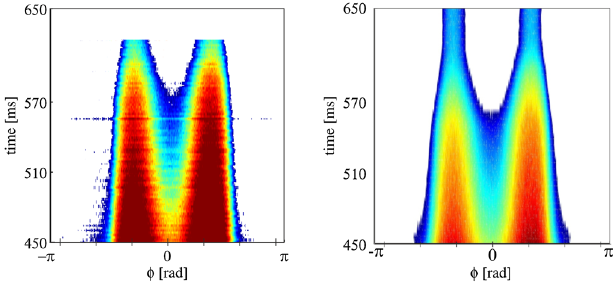
shortening.FIG. 5. Half-integer (long bunch): measured (left) and simulated (right) waterfall color plot in the time window [450 – 620] ms. The color code is the particle density (blue, low density — red, high